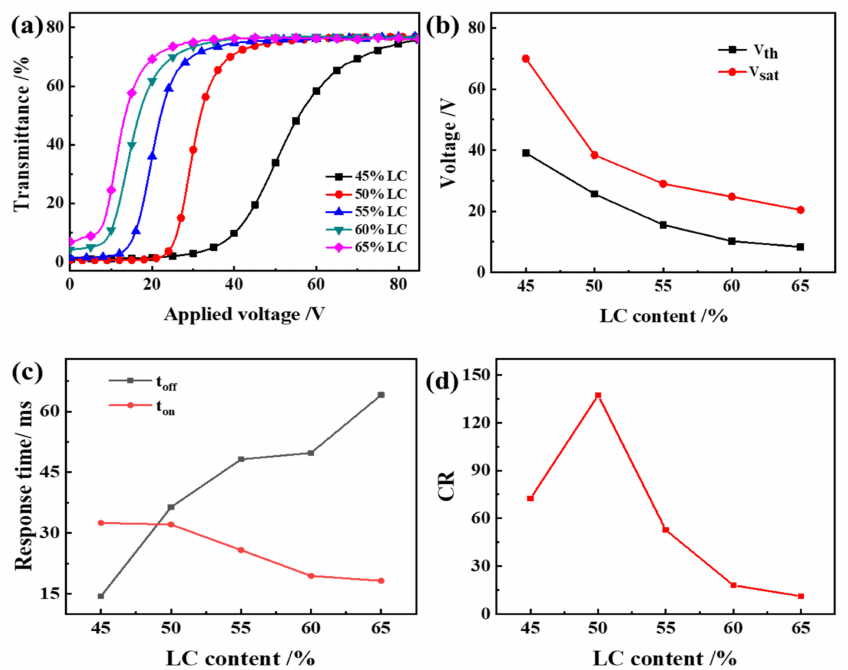
Figure 6. The effect of liquid crystal content on the electro-optical performance of PDLC ( a ) applied electric field (100 Hz) dependence of the transmittance of samples b1~b5; ( b ) V th and V sat of samples b1~b5; ( c ) Response time of samples b1~b5; ( d ) CR of samples